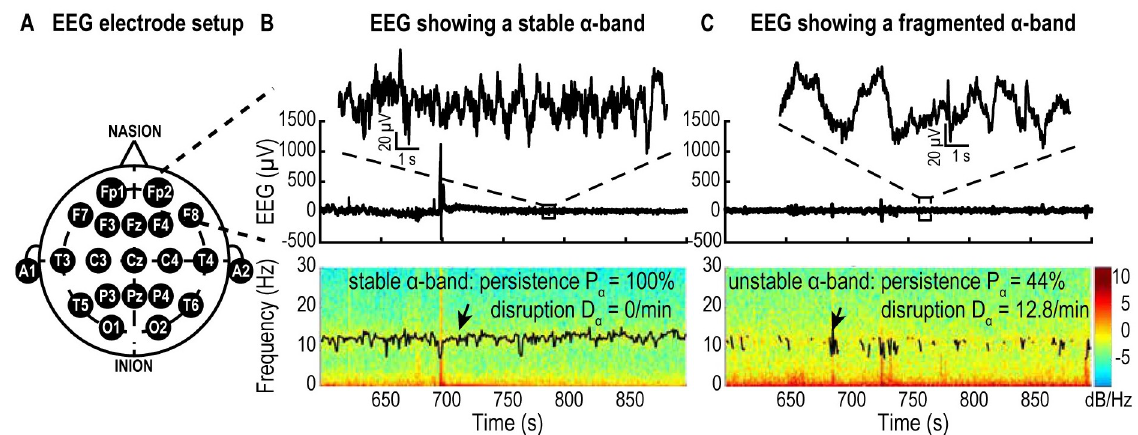
Fig 1. EEG recordings in patients during general anesthesia. A: Schematic of EEG electrode setup on a patient’s head. B: Upper: Time recordings showing the EEG (inset: 5 s). The EEG signal is composed of multiple bands as shown in the spectrogram (lower panel) composed of two major bands: the δ -band (0–4Hz) and the α -band (8–12Hz) tracked by its maximum (black curve) revealing the persistence of the α - band during anesthesia. The color indicates power in dB/Hz (see colorbar). C: Same as A for a case of fragmented α -band. Data from the database VitalDB